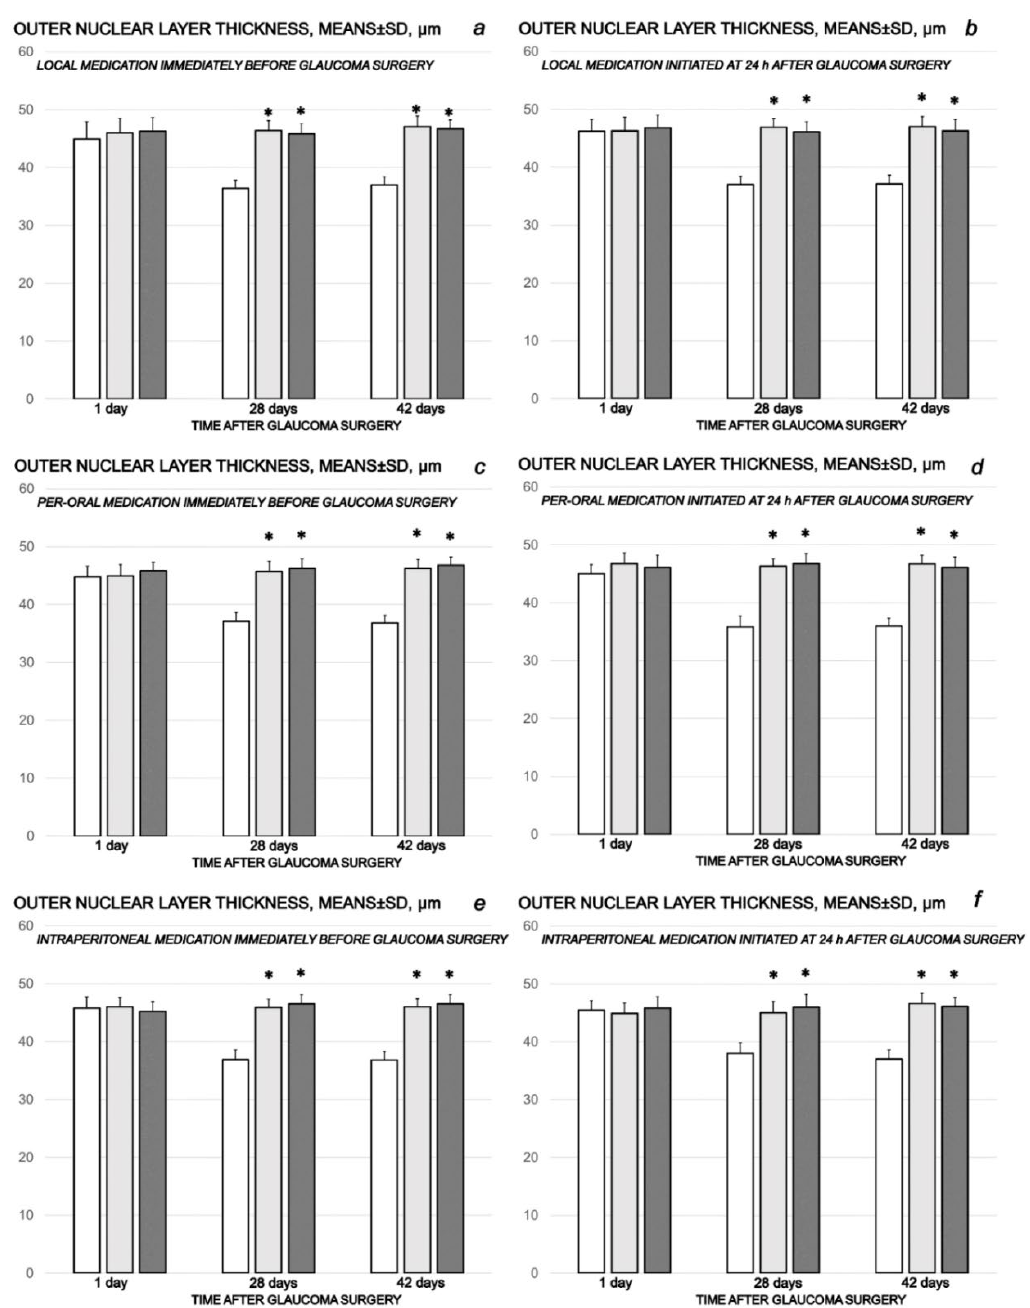
Figure 9. Cauterization of the three episcleral veins induced a decrease in retinal outer nuclear layer thickness, means ± SD, µ n, at the first post-operative day and at the end of the fourth and sixth post-injury week. Counteracting effect of BPC 157 medication daily regimen, prophylactic ( a – c ) or curative ( d – f ) (gray bars, light gray bars µ g-regimen, dark gray bars ng-regimen (0.4 µ g/eye, 0.4 ng/eye; 10 µ g/kg, 10 ng/kg) given locally as eye drops in each eye ( a , d ), intraperitoneally (last application at 24 h before sacrifice) ( b , e ) or per-orally in drinking water (0.16 µ g/mL, 0.16 ng/mL, 12 mL/rat until the sacrifice, first application given intragastrically) ( c , f )), started prophylactically (immediately before glaucoma surgery) or as curative treatment (at 24 h after glaucoma surgery). Controls (white bars) simultaneously received an equal volume of distilled water (two drops/eye), saline intraperitoneal application (5 mL/kg) or per-oral drinking water (12 mL/day/rat. A total of 6 rats/group/interval. * p < 0.05, at least, vs.